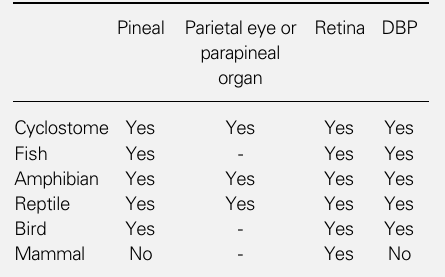
Table 2 - Distribution of circadian photoreceptors within the vertebrate central nervous system. Extraretinal photoreceptors are present in all the vertebrate classes, except mammals. DBP, Deep brain